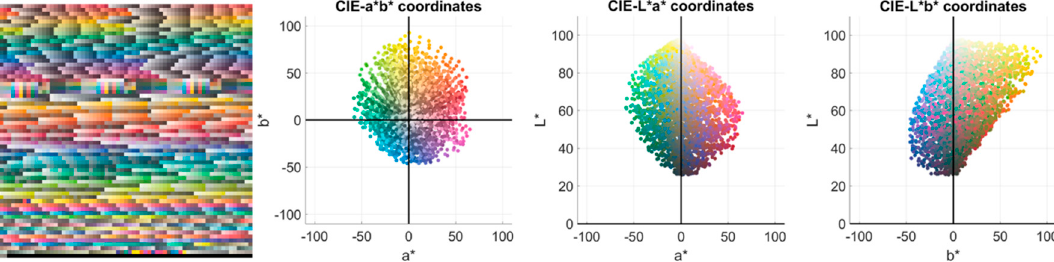
Figure 1. sRGB (i.e. the standard RGB space [33]) rendering of the 4,233 samples present in D1 under illuminant D65, and their L*a*b* projections.